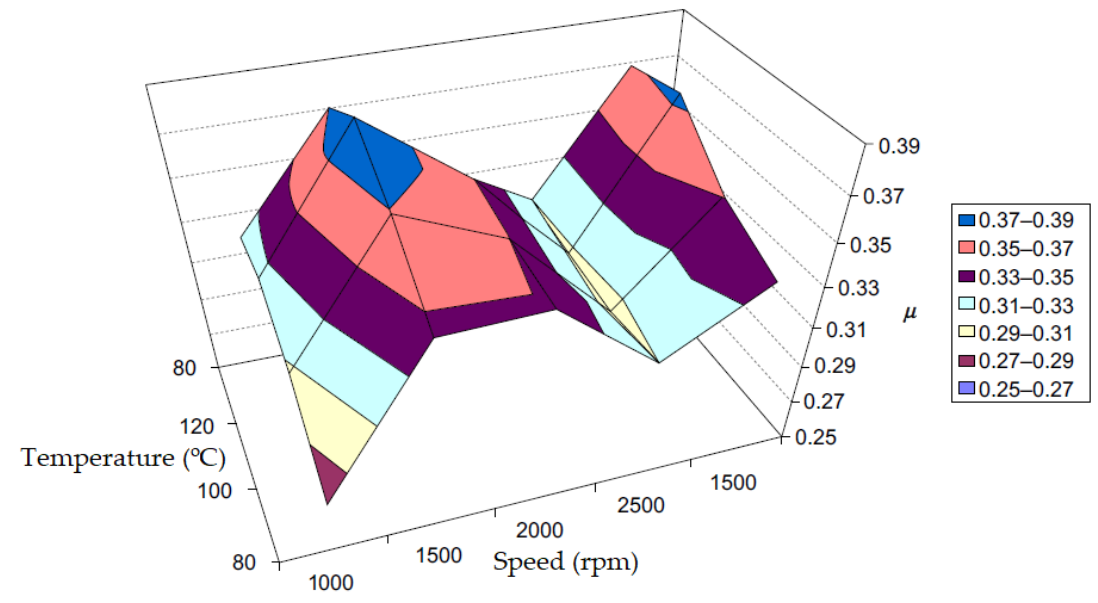
Figure 9. Effect of temperature and velocity on the surface of the friction composite (reprinted/adapted with permission from ref. [13]. 2022, Elsevier).